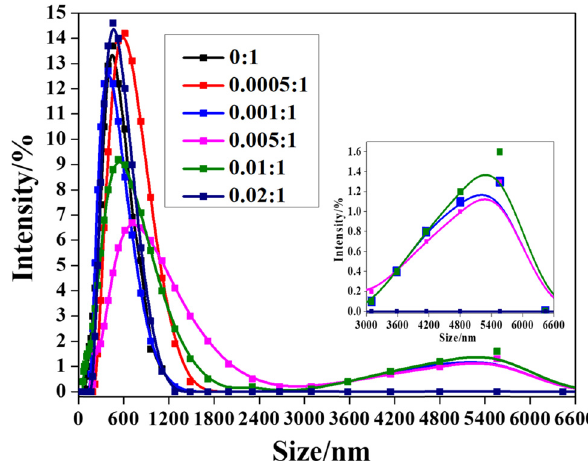
Figure 2: Size distributions of DSPE – PEG2k/PDLLA – MPEG complex aggregates prepared from the DSPE – PEG2k/PDLLA – MPEG mixed solutions at di ff erent mass ratios of DSPE – PEG2k/PDLLA –